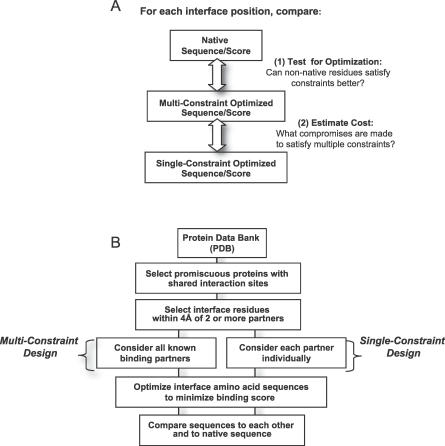
Computational Strategy and Methodology Flowchart(A) Computational strategy for determining the degree of optimization and predicted cost of multi-specificity.(B) Flowchart illustrating the methodology for generating a dataset of multi-specific proteins and computational protocol for predicting sequences optimal for each binding interaction alone (single-constraint) as well as sequences predicted to satisfying binding in the context of all structurally characterized partners (multi-constraint).